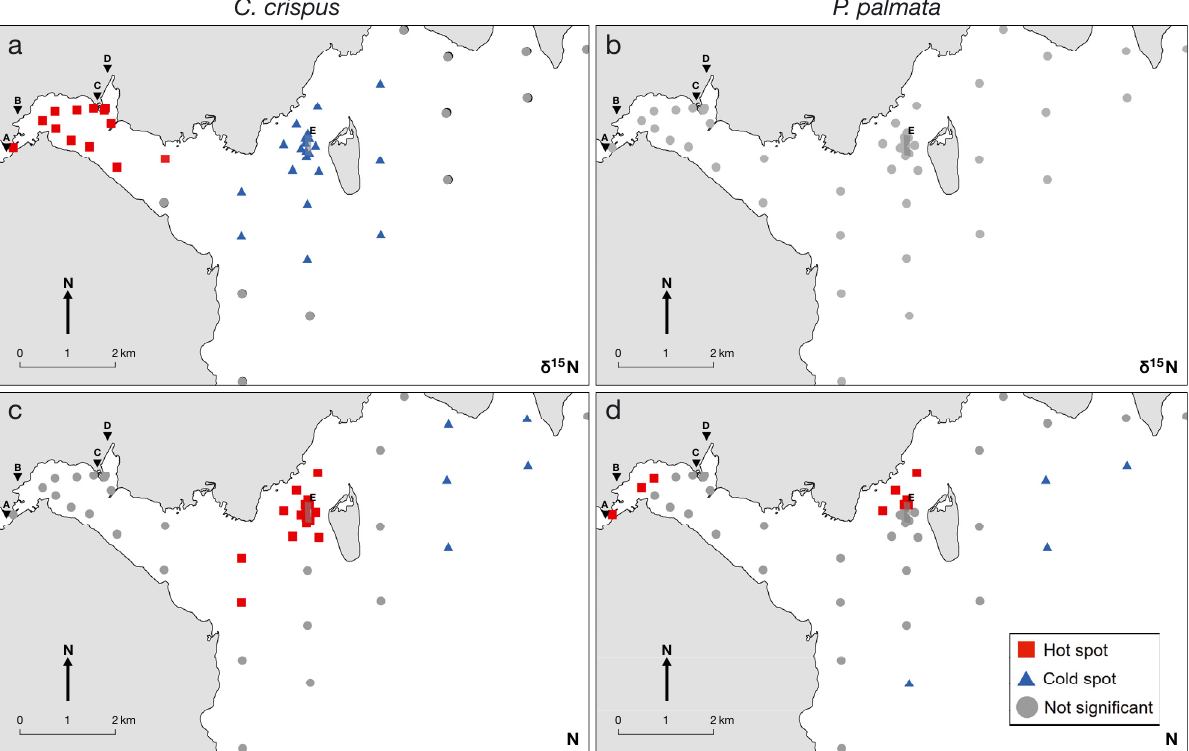
Fig. 4. Hot-spot analysis of (a,b) δ 15 N and (c,d) N content of the macroalgae Chondrus crispus (a,c) and Palmaria palmata (b,d). Triangles indicate probable point sources (labelled as in Fig.